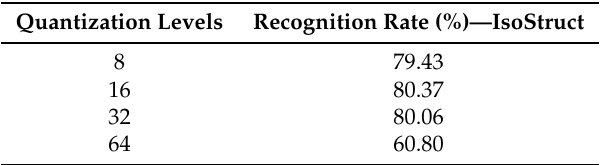
Table 7. Fingerprint classification results with the IsoStruct features vector.